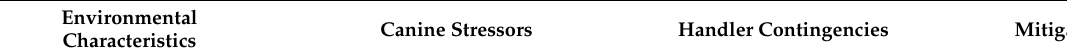
Table 1. Canine Stress Mitigation Strategies for Animal-assisted Activity